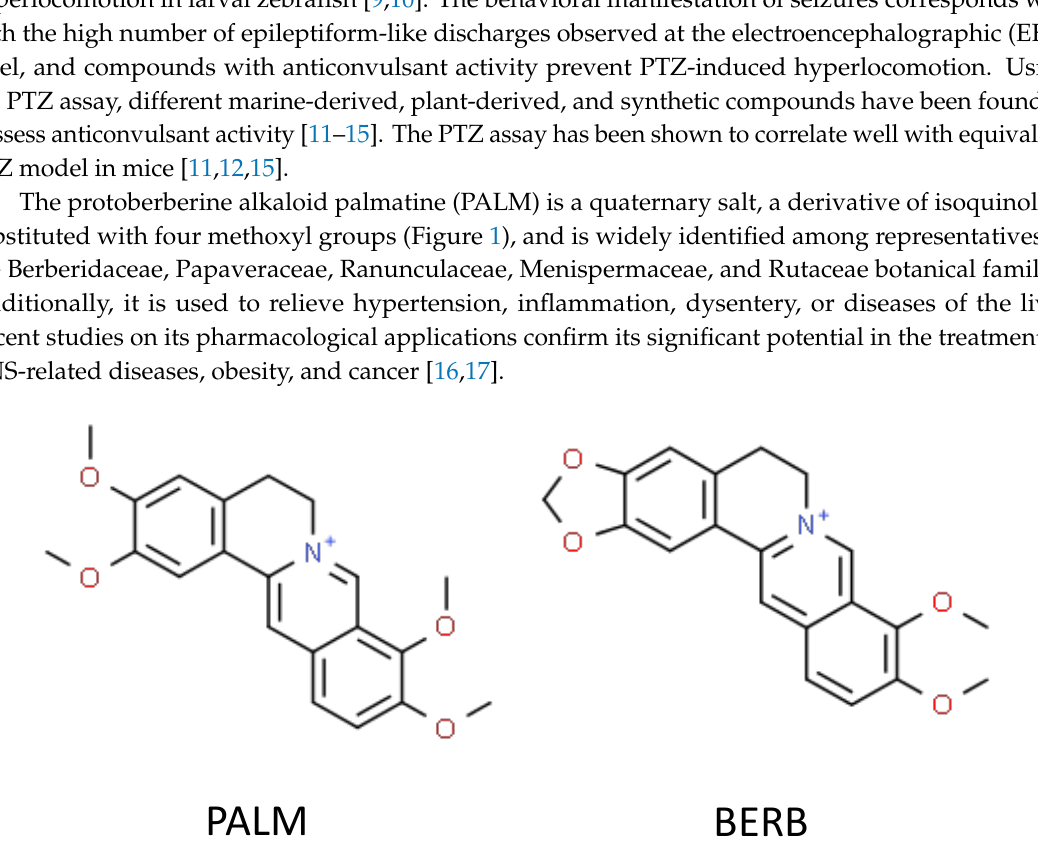
Figure 1. The chemical structure of palmatine (PALM) and berberine (BERB).